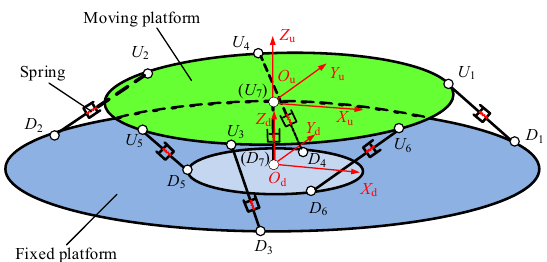
Figure 7 The 7-SPS passive-input overconstrained